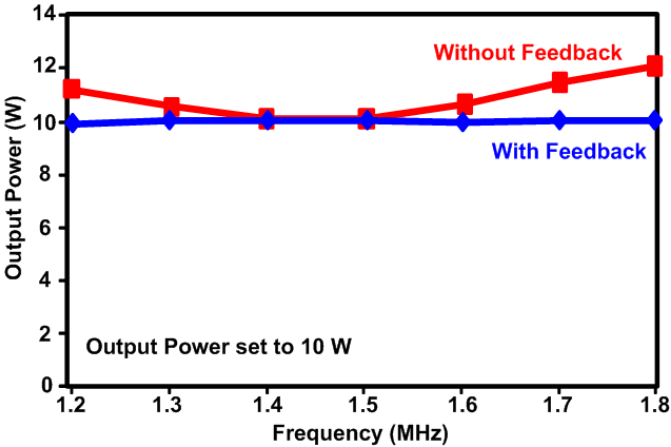
Figure 2. The output power applied to a 50 Ω load with and without feedback, reproduced from